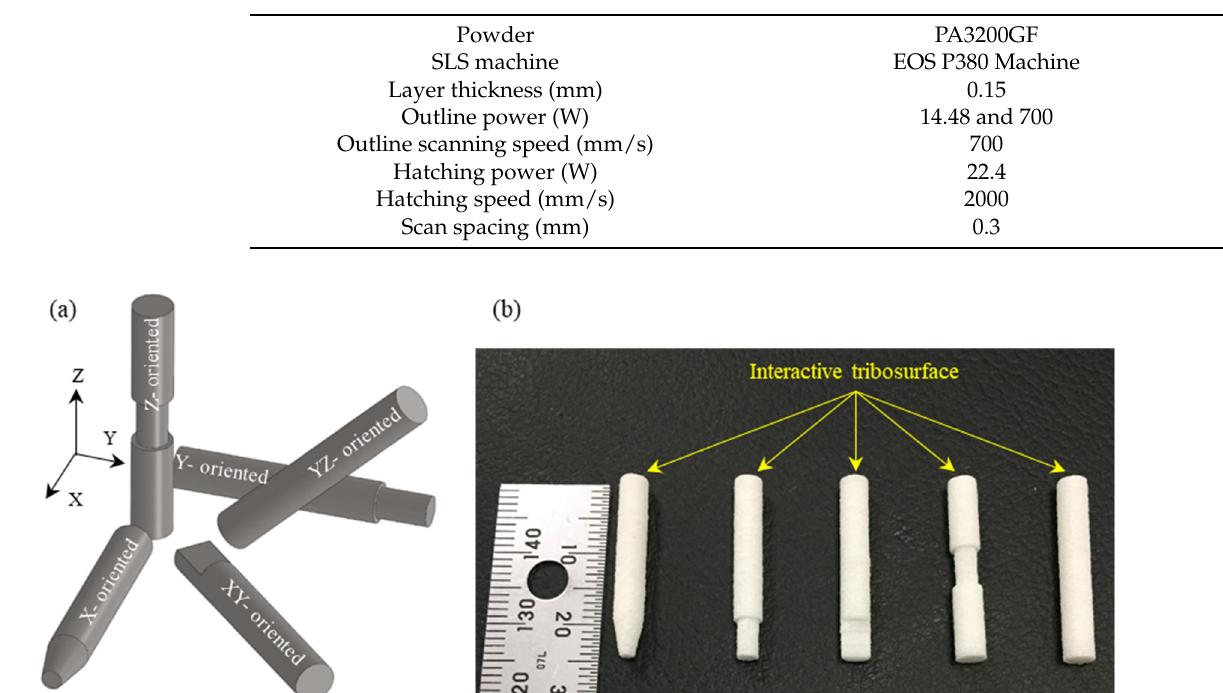
Table 1. SLS of PA 3200 GF test specimens.